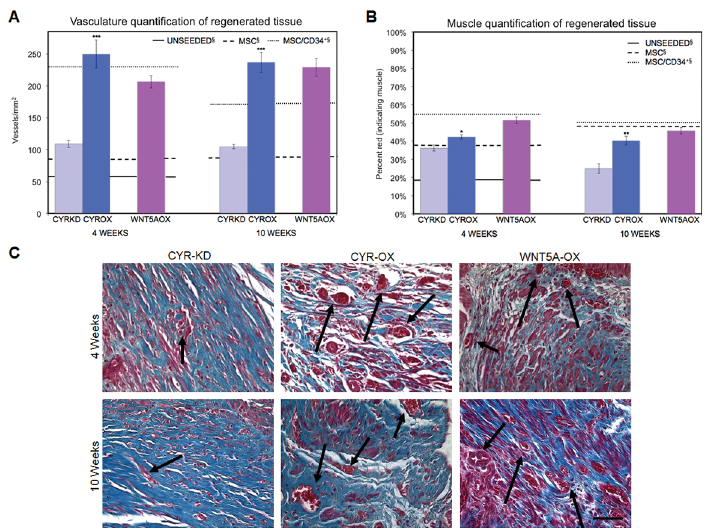
Fig 2. Effects of Cyr61 and Wnt5a on regenerating vasculature and musculature. (A) Cyr61OX and Wnt5aOX showed early and persistent increased vasculature, comparably greater than unmanipulated MSCs, with numbers of vessels/mm 2 similar to MSC/CD34 + HSPC grafts at 4 weeks. (§ Unseeded, MSC and MSC/CD34 + HSPC data, shown as solid and dotted lines, previously reported [7]). At both 4 and 10 weeks, Cyr61KD demonstrated significantly decreased vasculature as compared to Cyr61OX. Data shown as means ± SEM; *** P < 0.001 for Cyr61KD vs Cyr61OX. (B) Wnt5aOX demonstrated mean muscle content most comparable to MSC/CD34 + HSPC grafts [percent red (muscle): (red (muscle) pixels / red (muscle) + blue (collagen) pixels)]. (§ Unseeded, MSC and MSC/CD34 + HSPC data, shown as solid and dotted lines, previously reported [7]). Cyr61KD demonstrated a significant decrease in muscle percentage from 4 to 10 weeks (p < 0.05), with levels significantly lower than Cyr61OX at both time points. Data shown as means ± SEM; * P < 0.05 and ** P < 0.01 for Cyr61KD vs Cyr61OX. (C) Sample photomicrographs of Masson ’ s trichrome staining demonstrate differences in muscle/collagen content and level of vasculature (marked with black arrows) between Cyr61KD and the Cyr61OX and Wnt5aOX groups. Density score was greatest for Wnt5aOX at 4 weeks. Scale bar, 50 μ m. (Unseeded, MSC and MSC/CD34 + HSPC images shown in S1